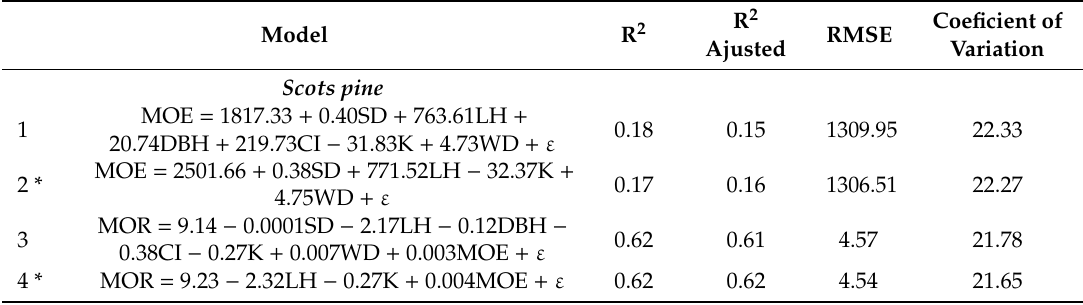
Table 6. The selected models ( p < 0.05 for all parameters) determined by the stepwise procedure to describe wood quality characteristics of MOE and MOR in relation to stand and tree characteristics (SD, stand density; LH, log height; DBH, diameter at breast height; K, knot diameter; WD, wood density) in Scots pine and Norway